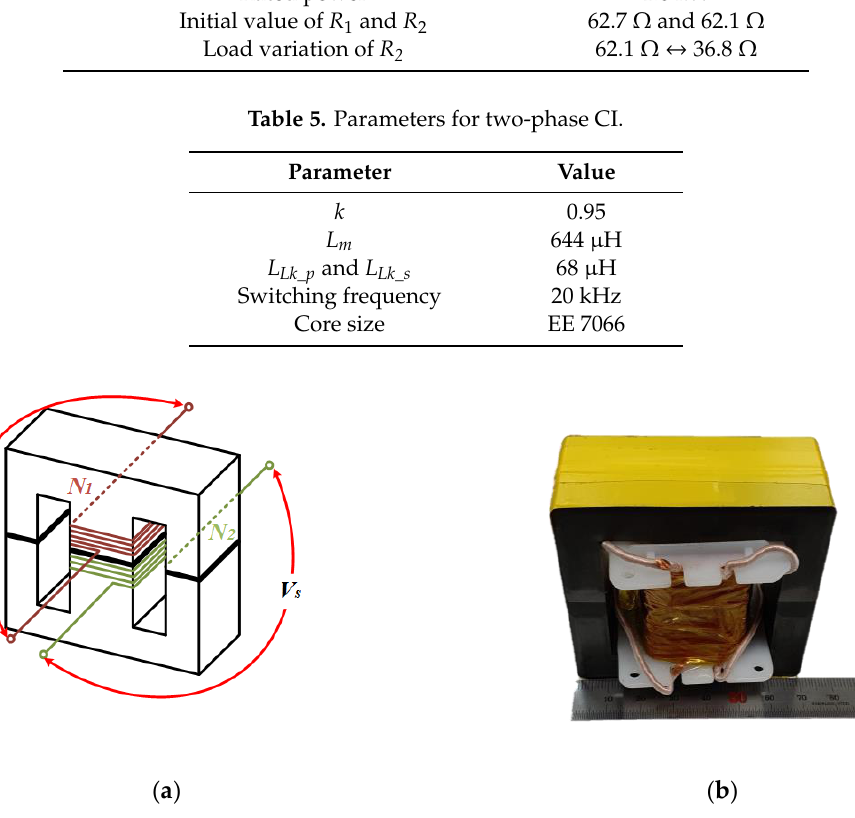
Figure 10. Structure of two-phase CI using EE core: ( a ) the EE core structure and windings of CI, ( b ) the experimental prototype of CI.